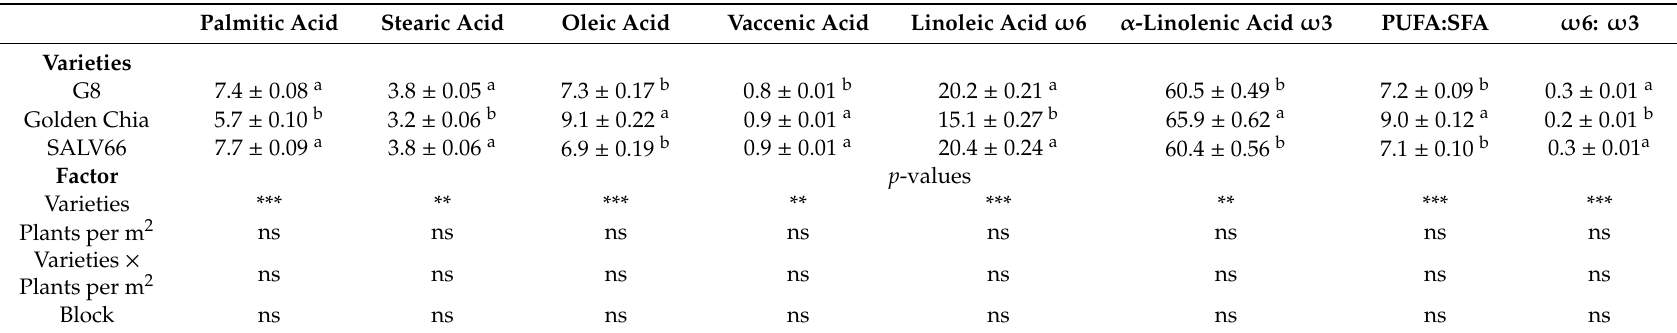
Table 7. Fatty acid composition (% of total fatty acid) of three chia varieties (G8, Golden Chia, SALV66) cultivated at IHO in 2018 ( n = 3, α = 0.05, mean ± standard